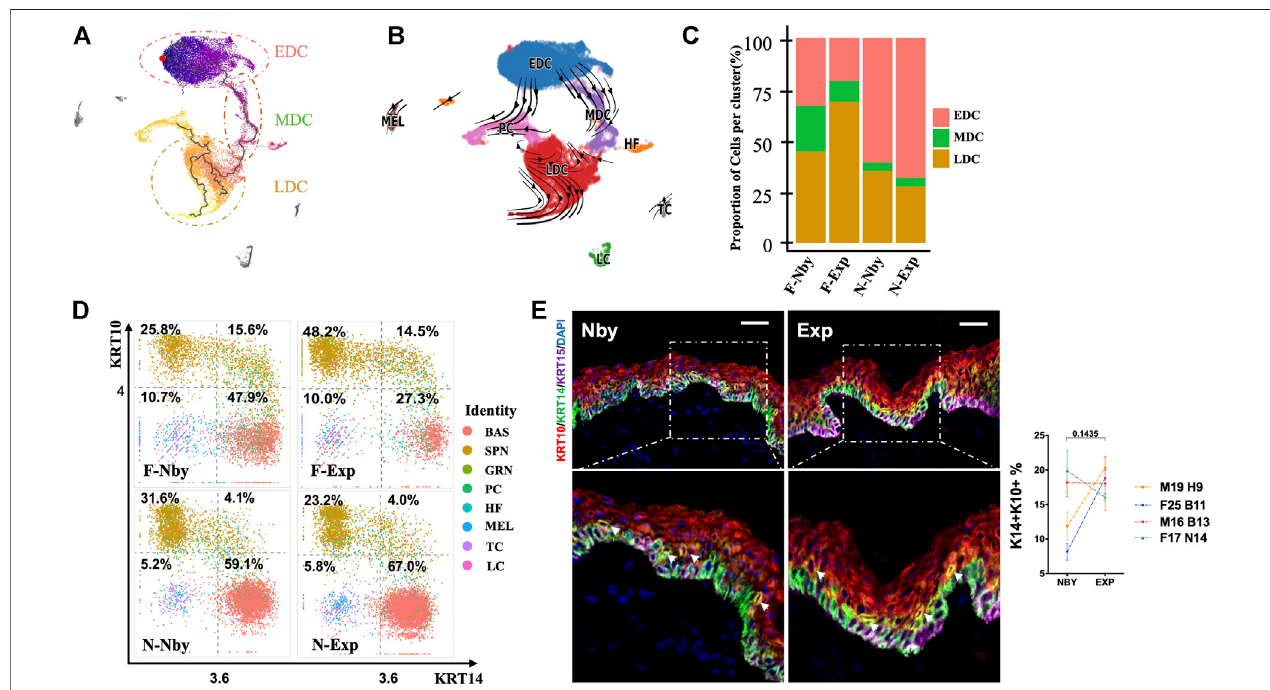
FIGURE2| EpidermismaintainedasimilarlineagetrajectorytoitscounterpartsafterLTE. (A) Monocle3pseudotemporalvisualizationofalltheepidermalcelltypes along differentiation trajectories from dark purple to light yellow. The root cell was indicated in red, and the edges are shown as black line segments. Clusters were de fi nedfromearlytolateaccordingtotherankofpseudotemporalcellordering. (B) Velocitiesderivedfromthedynamicalmodelforepidermaldifferentiatedtrajectoryare visualized as streamlines in a UMAP-based embedding. Cells are color-coded by clusters. (C) The fraction of rede fi ned clusters in each sample. (D) Two- dimensional scatter plots of KRT14 and KRT10 expression in all cell types. Note that there is no increasing fraction of KRT14 high and KRT10 high cells located in the right upper quadrant (RUQ) after long-term expansion. (E) Representative IF images of the nearby and expanded skin. KRT14 and KRT10 co-expressed cells (yellow with arrows) and the quanti fi cation of their fraction in epidermal